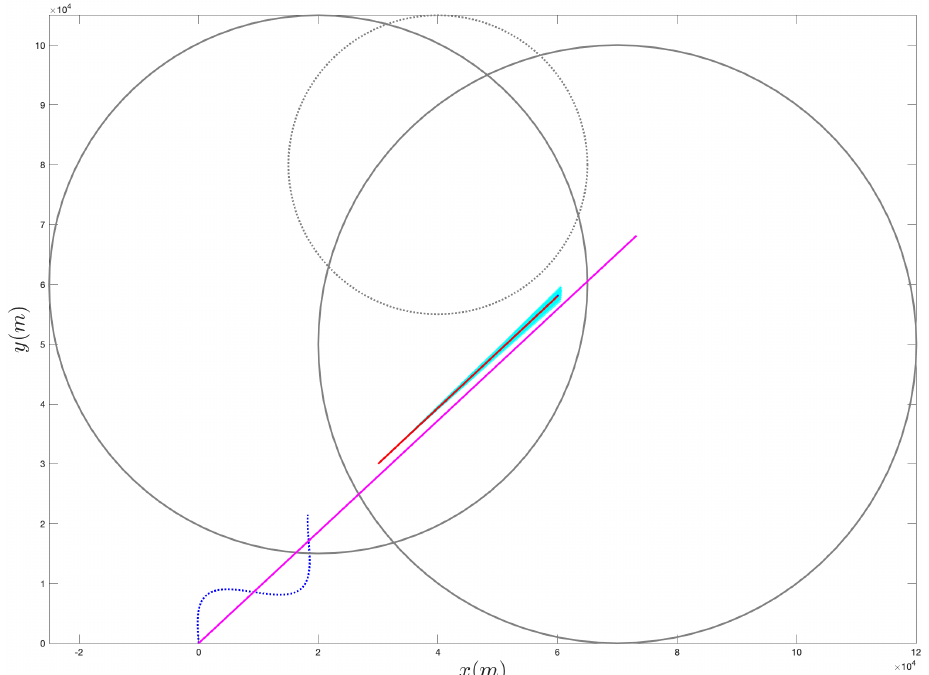
Figure 4. Sampling of 100 trajectories (in cyan) based on the average solution found via the proposed approach and on the experimental covariance matrix.